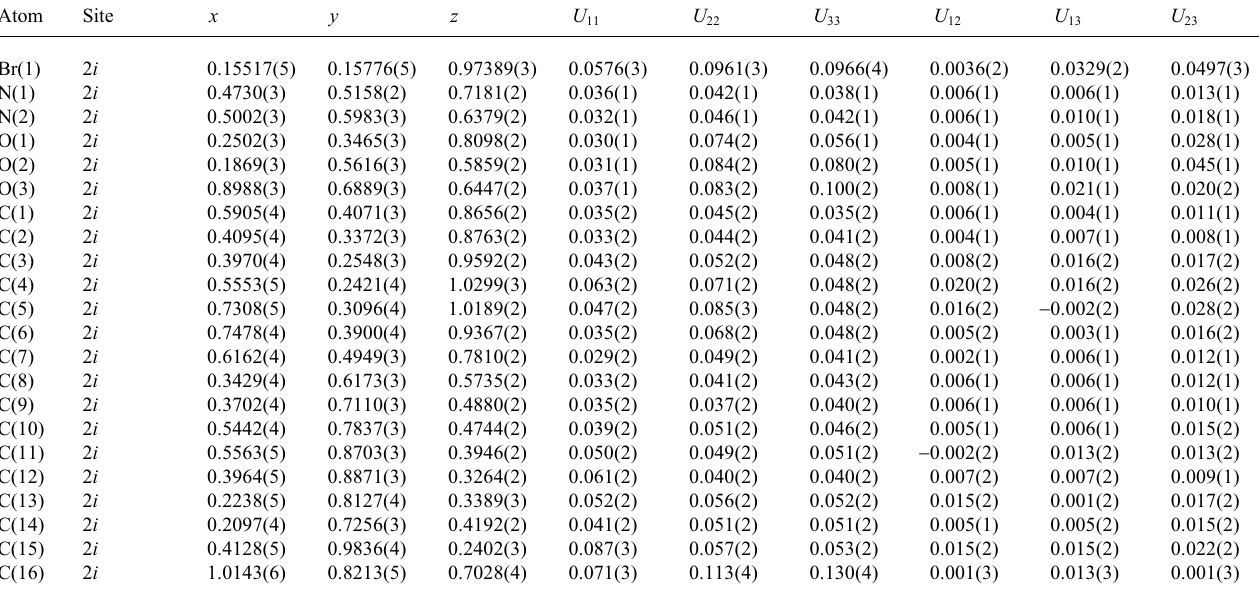
Table 3. Atomic coordinates and displacement parameters (in Å 2 )